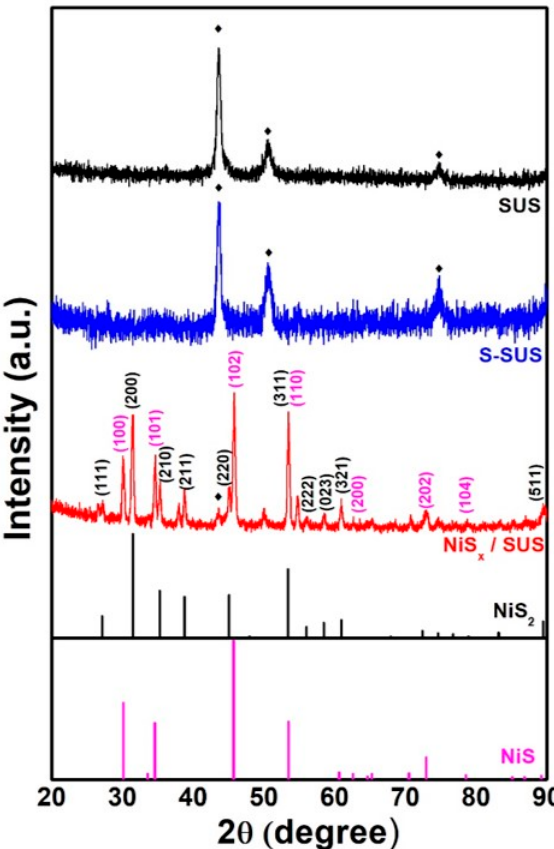
Figure 3. X-ray di ff raction analysis of SUS (black), S-SUS (blue), and NiS x / SUS (red) with JCPDS No. Figure 3. X-ray diffraction analysis of SUS (black), S-SUS (blue), and NiS x /SUS (red) with JCPDS No. 01-089-7142 (NiS 2 ) and 03-065-3419 01-089-7142 (NiS 2 ) and 03-065-3419 (NiS).